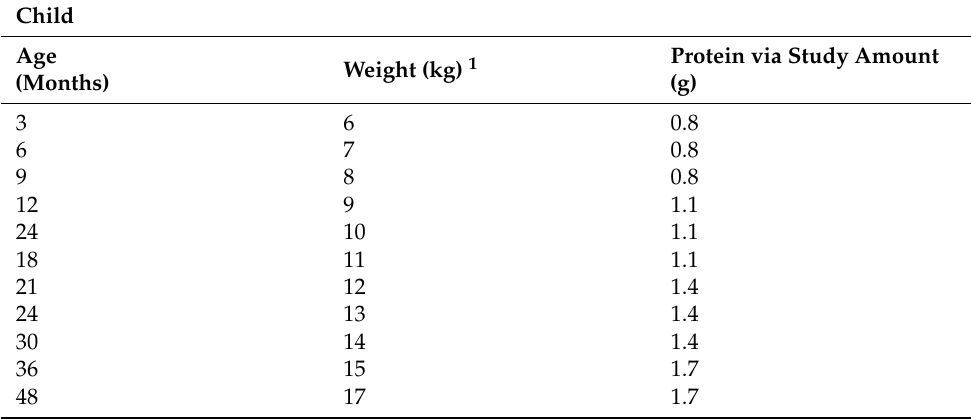
Table 1. Daily dosages of the iAGE product during treatment.